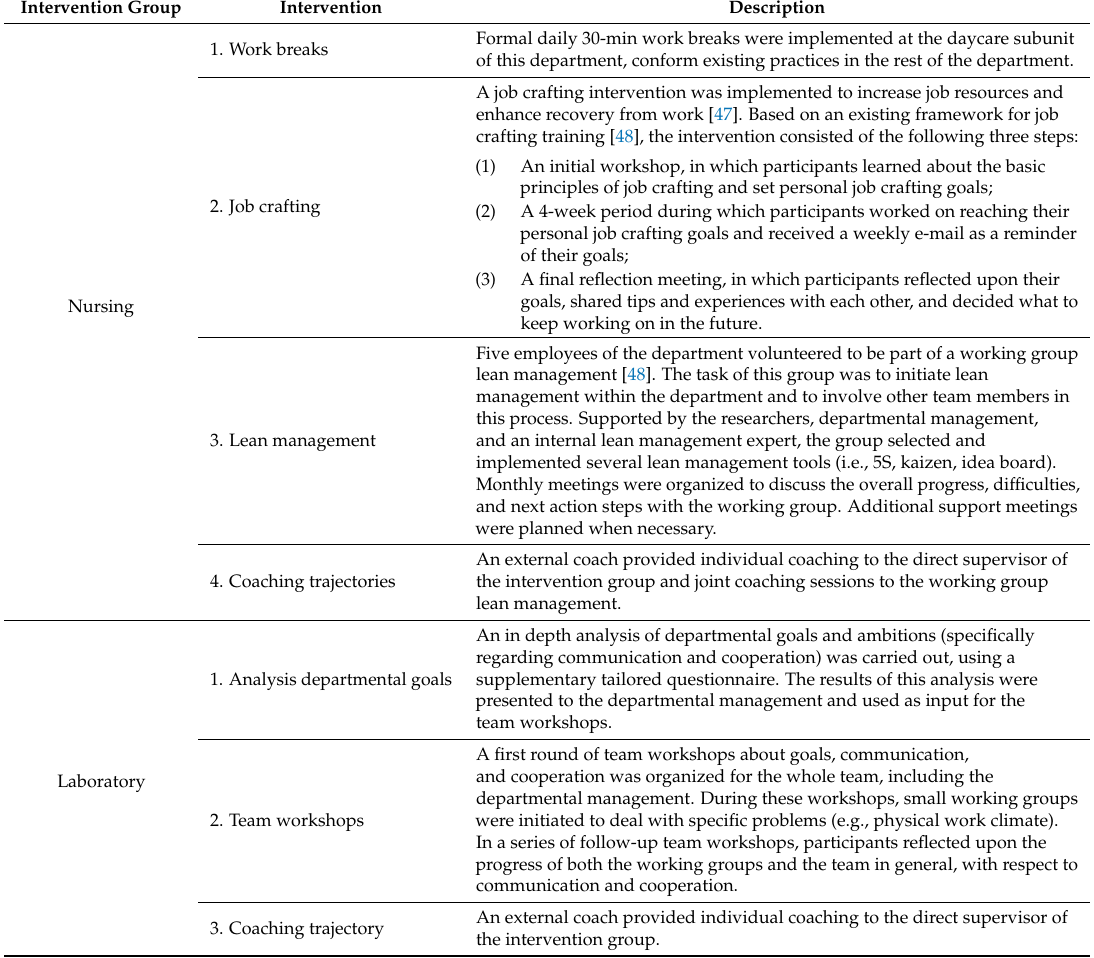
Table A1. Description of